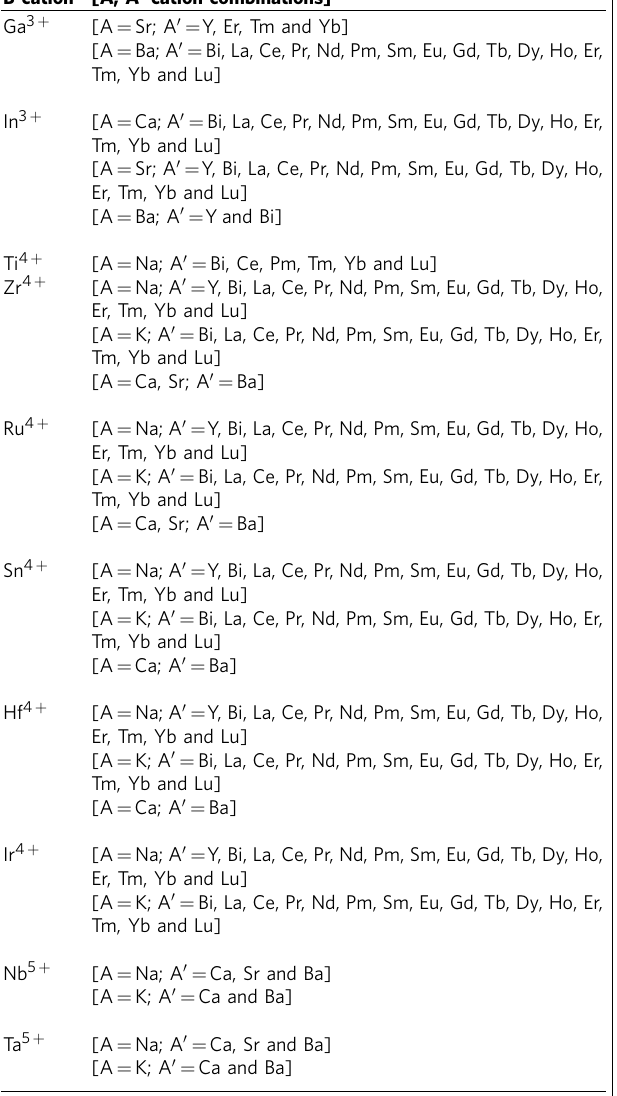
Table 3 | Full list of 242 predicted AA 0 BO 4 RP compounds from classification learning that show propensity towards NCS